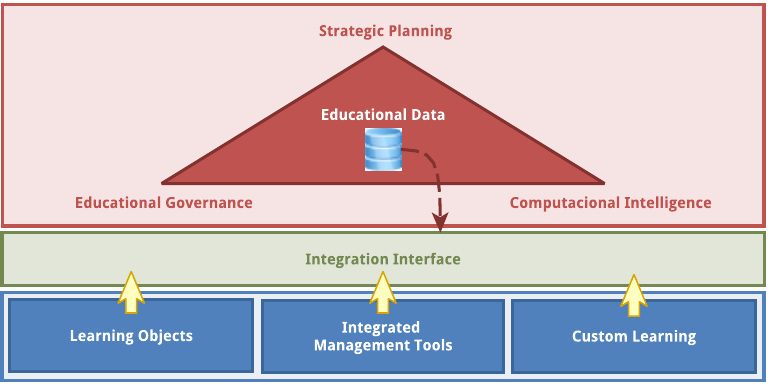
Figure 3. Edukas environment conceptual